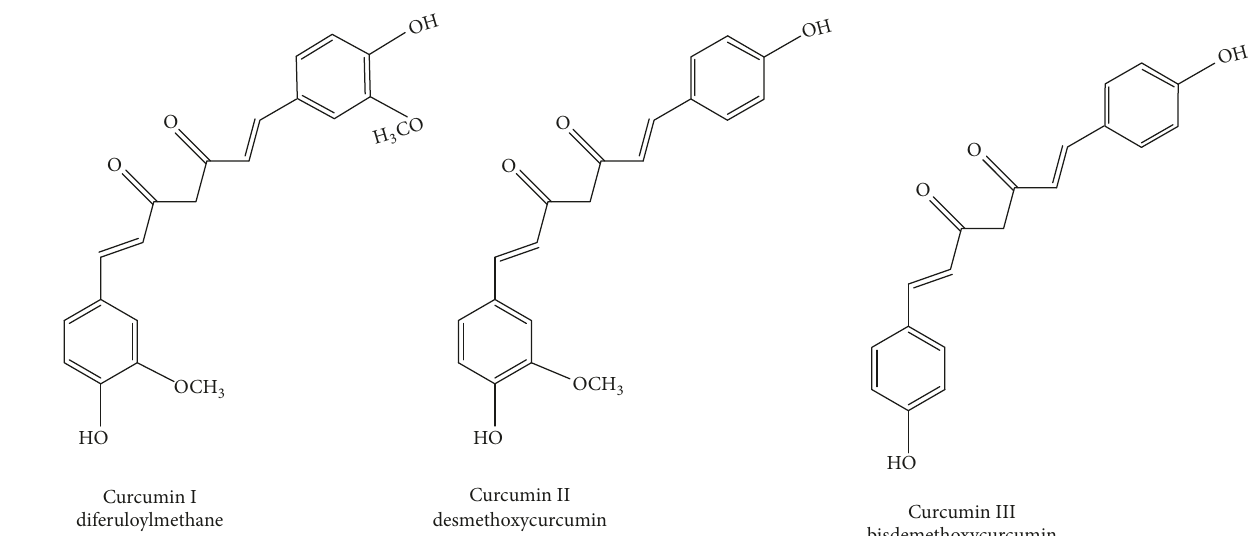
Figure 1: Comparing the structure of the three